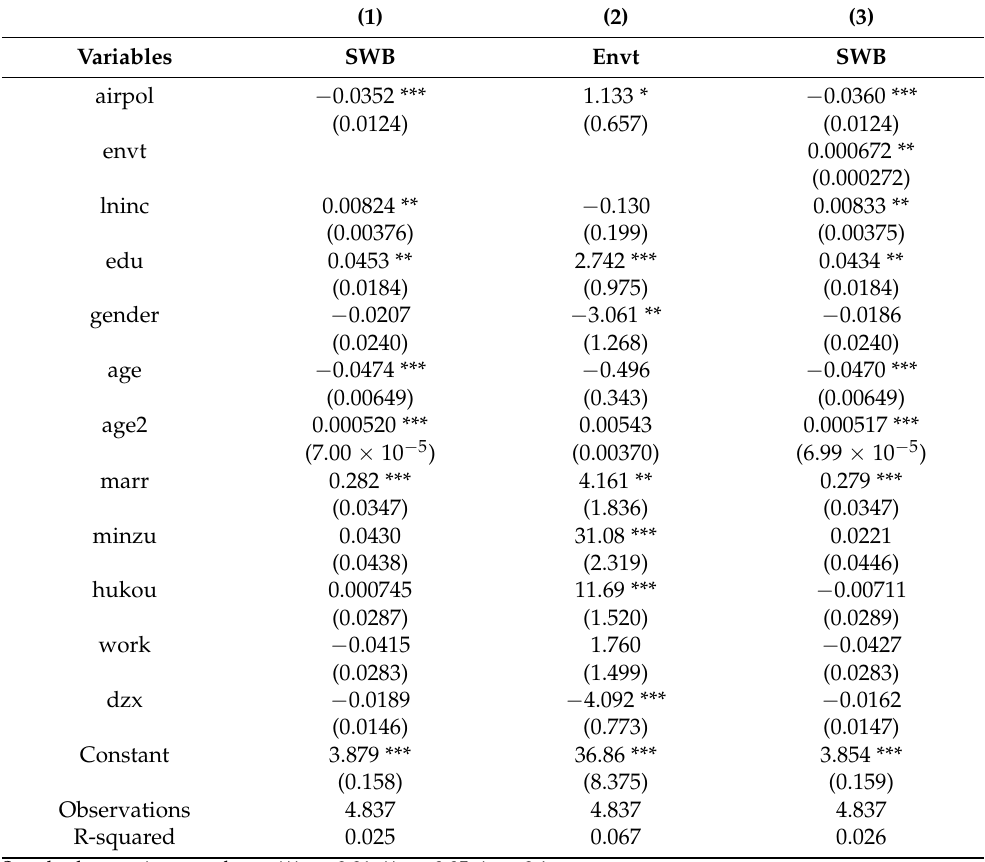
Table 2. Regression